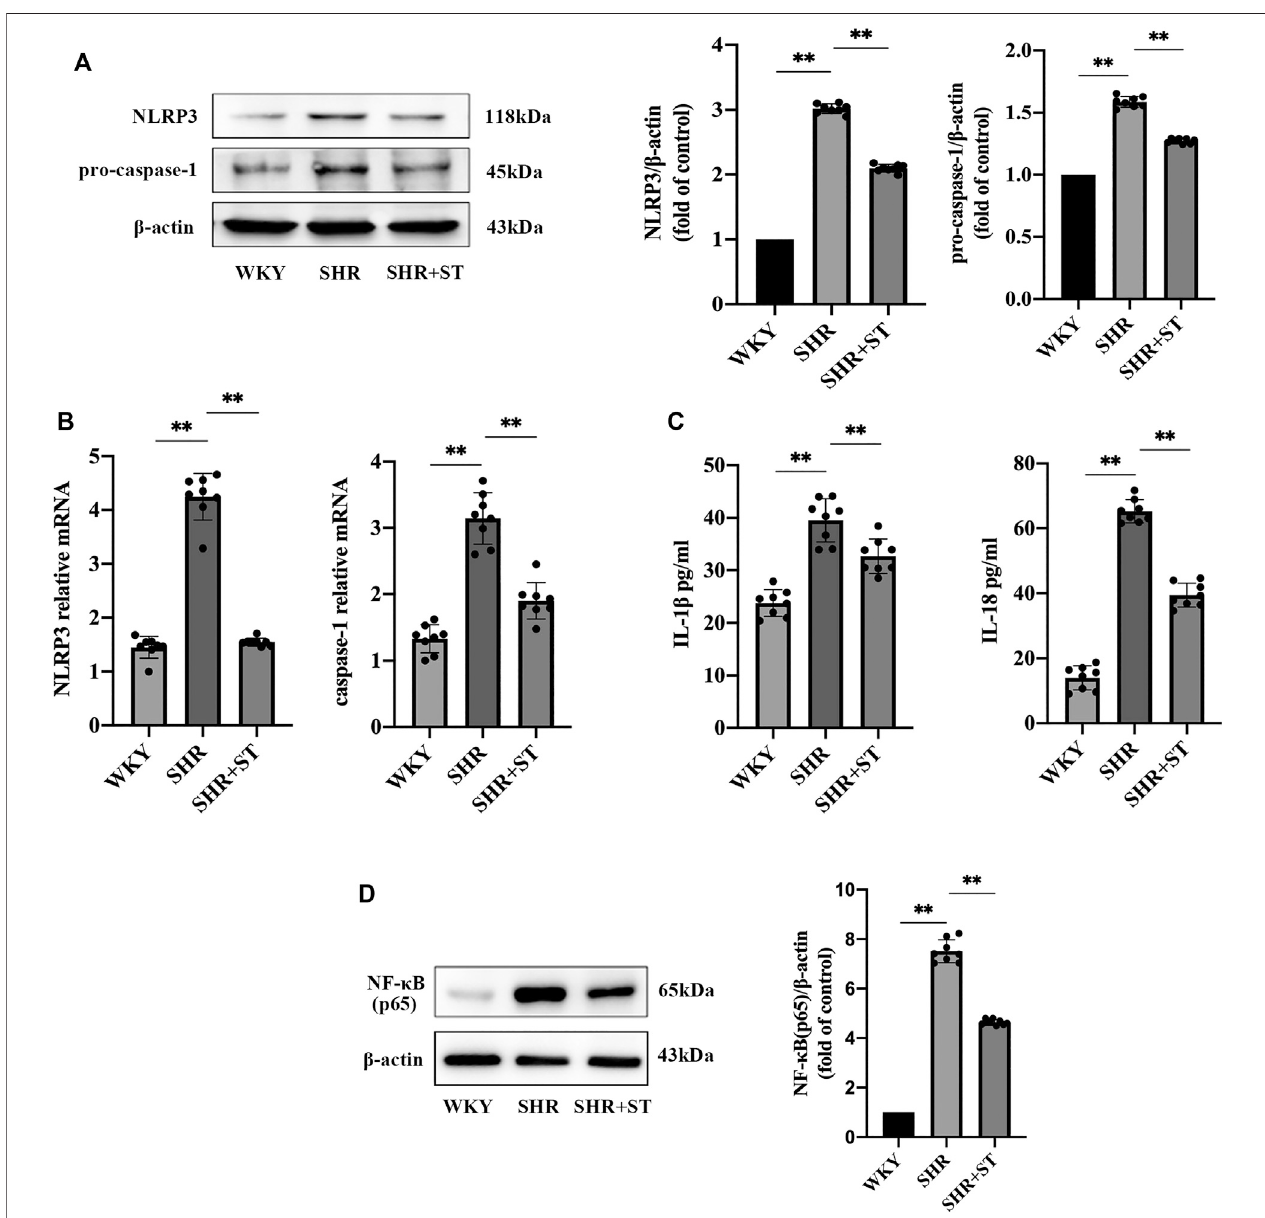
FIGURE 3 | ST inhibited the activation of NLRP3 in fl ammasome and attenuated in fl ammation in SHRs ( n (cid:2) 8). (A) Western blot analysis of NLRP3 and pro-caspase-1 in WKY,SHR,SHR+STgroups.Thedatawerepresentedinfoldofcontrol. (B) PCRanalysisoftheexpressionofNLRP3andcaspase-1inabovethreegroups. (C) ELISAanalysisof thelevelsofIL-1 β andIL-18inabovethreegroups. (D) WesternblotanalysisofNF- κ B(p65)inabovethreegroups.Thedatawerepresentedinfoldofcontrol.Alldatawereshown asmean ± standarddeviation(SD)(errorbars)fromeightindependentbiologicalrepeatsexperiments,eachofwhichincludedthreetechnicalrepeats.* p < 0.05; ** p <